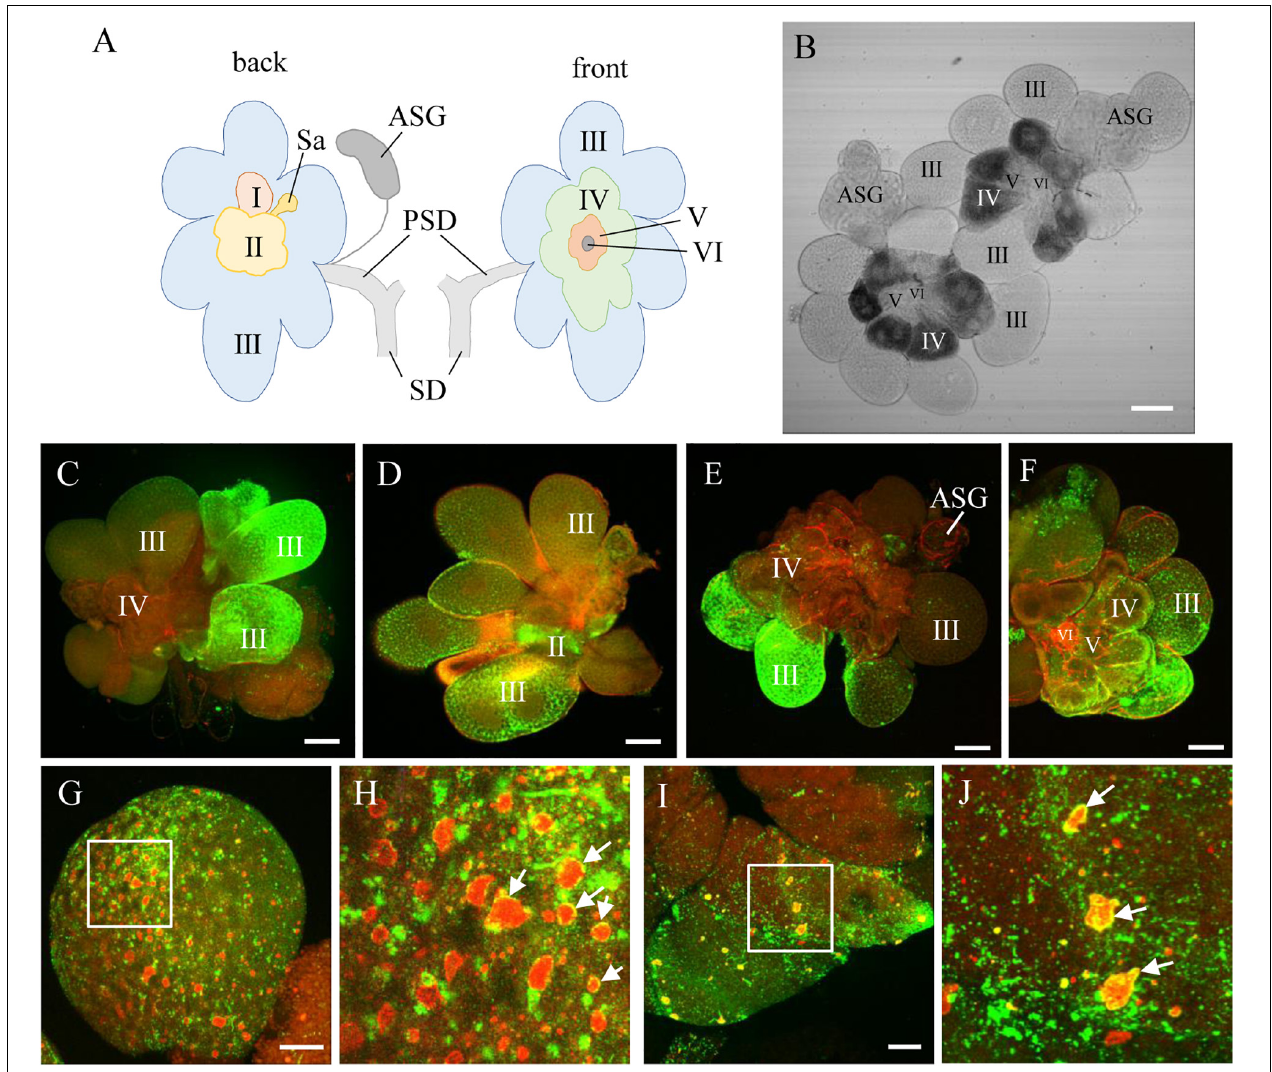
FIGURE 1 | RDV infection and replication in the salivary gland cells of viruliferous leafhoppers. (A) Schematic illustration of a salivary gland from an N. cincticeps leafhopper, modified from Sogawa (1965). (B) Transmission light micrograph of one pair of salivary glands from an N. cincticeps leafhopper. The principal